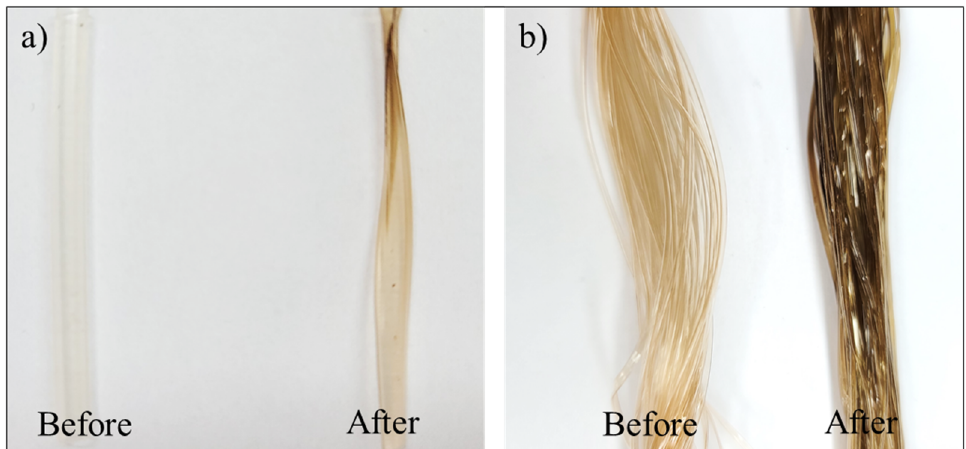
Figure 7. Color and texture of membranes of ( a ) NPD_NS and ( b ) HPD_NP before and after being left in the high temperature and humidity environment for around six months.